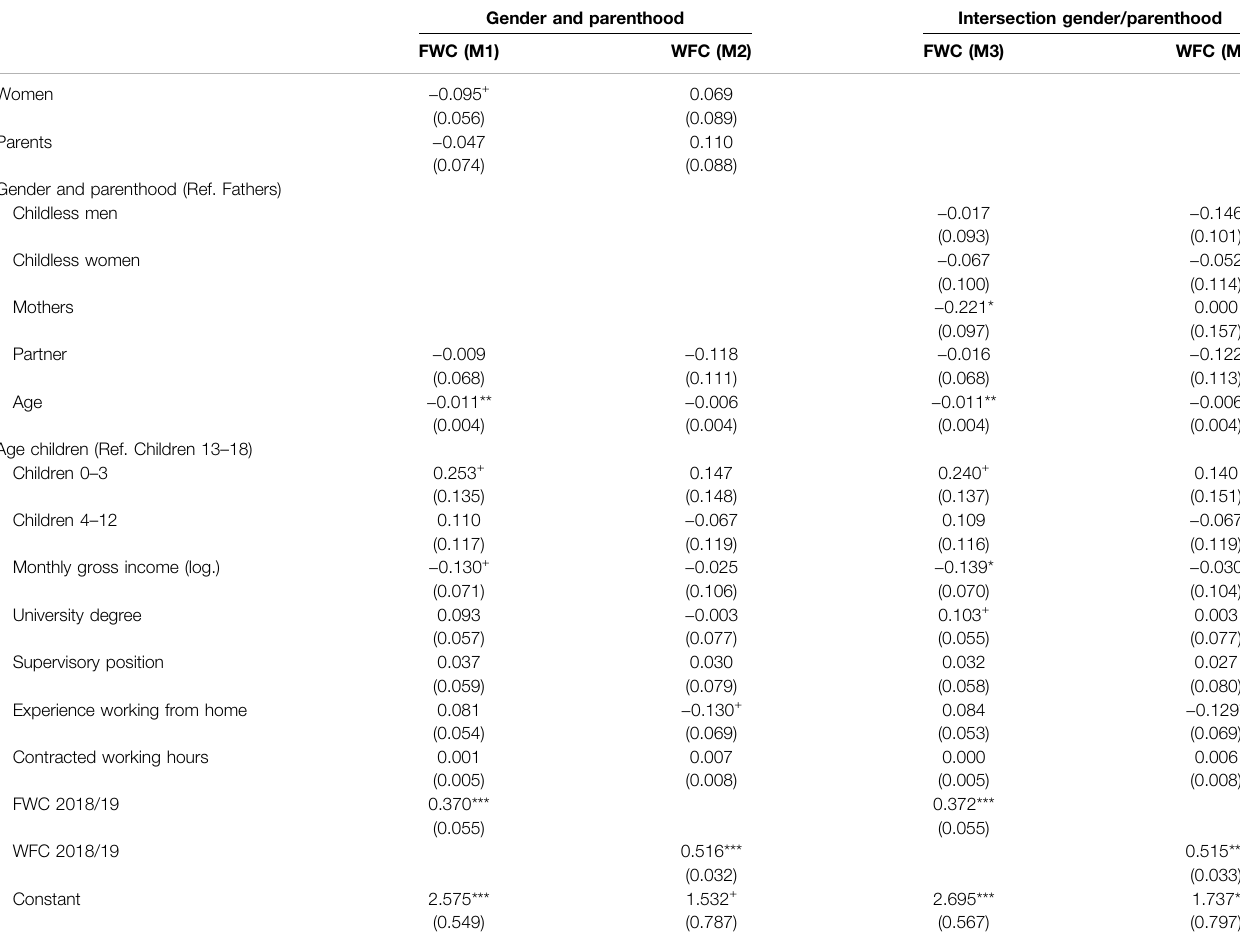
TABLE 5 | Linear regressions on employees ’ FWC and WFC by gender, parenthood, and the intersection of gender and parenthood ( N (cid:1) 660). Gender and parenthood Intersection